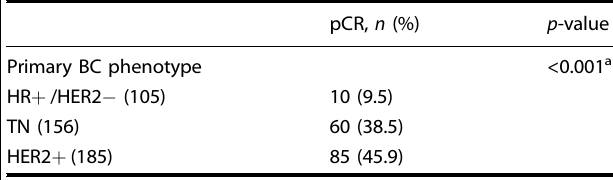
Table 2. Distribution of pCR rates according to tumor